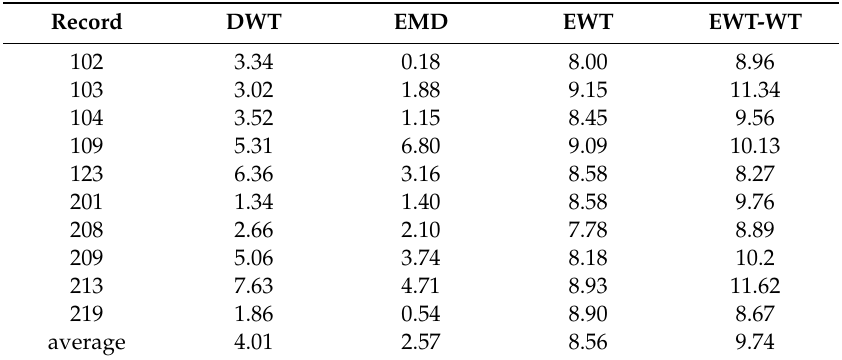
The SNR imp comparison of the denoising results of using DWT, EMD, EWT and EWT-WT